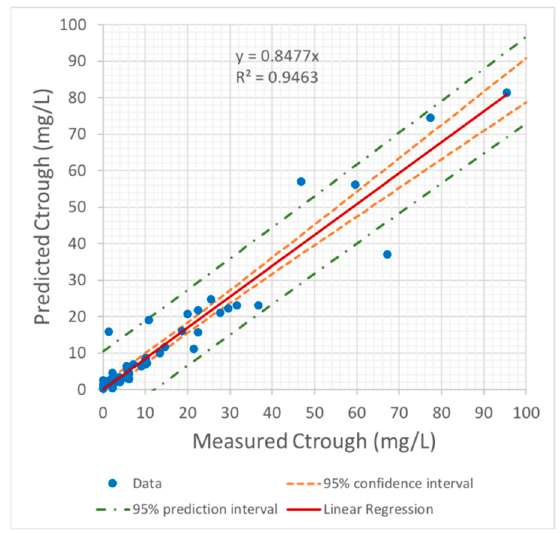
Figure 4. Correlation between predicted and measured C trough values.